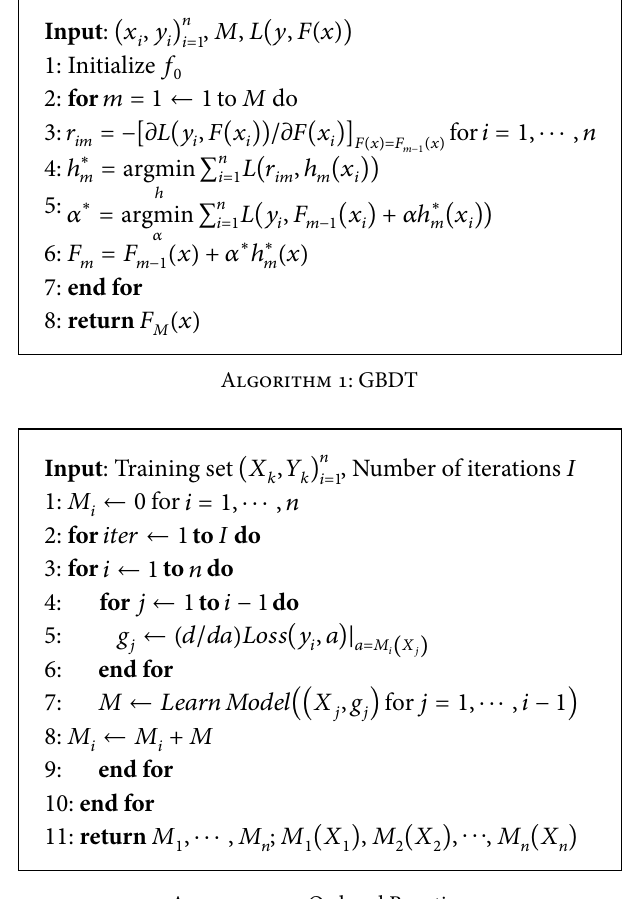
Figure 1. Three initial settings should be determined before running the